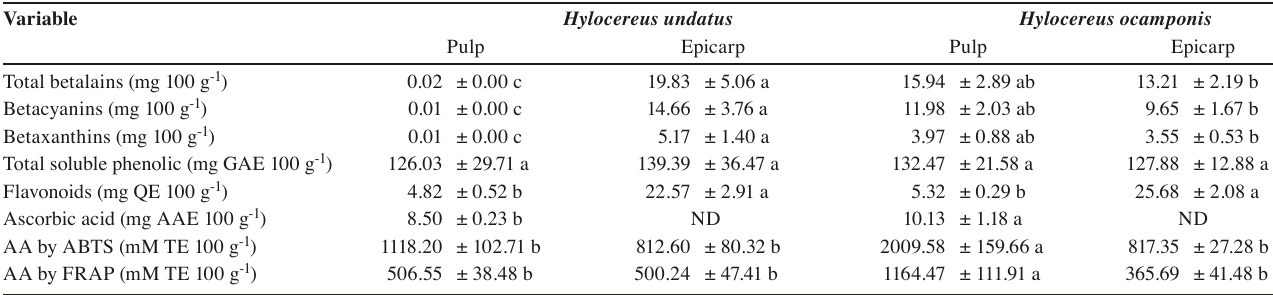
Tab. 4: Nutraceutical components and antioxidant activity (AA) in pulp and epicarp of pitahaya fruits with white ( Hylocereus undatus ) and red ( H. ocamponis ).